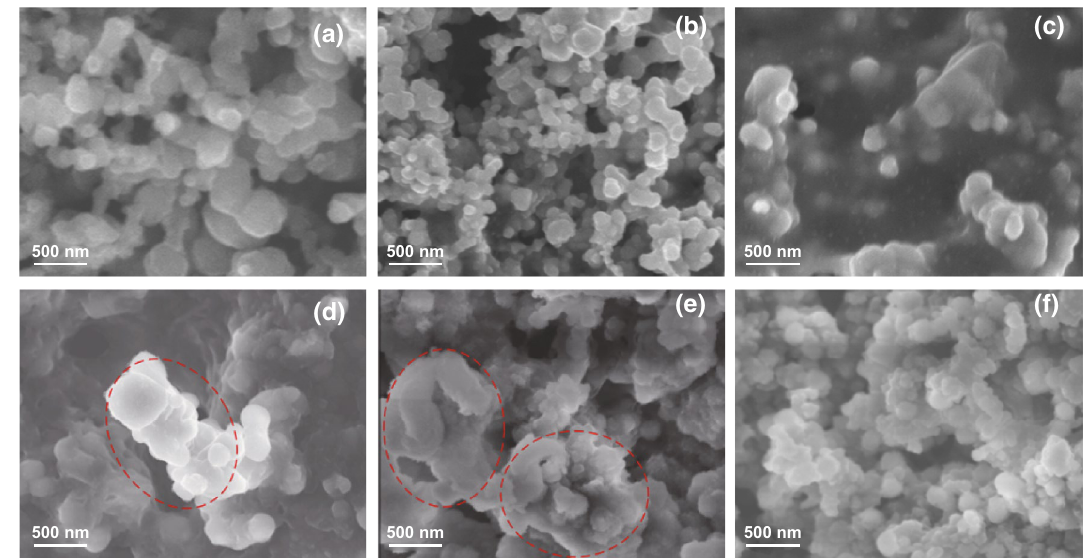
Fig. 5 SEM images of Si-PAA-SP ( a, d), Si-PEDOT:PSS (b, e), and SGP-10-180-60 ( c, f). Anodes before cycling ( a–c) and after cycling 200 times at 1.0 A g −1 (